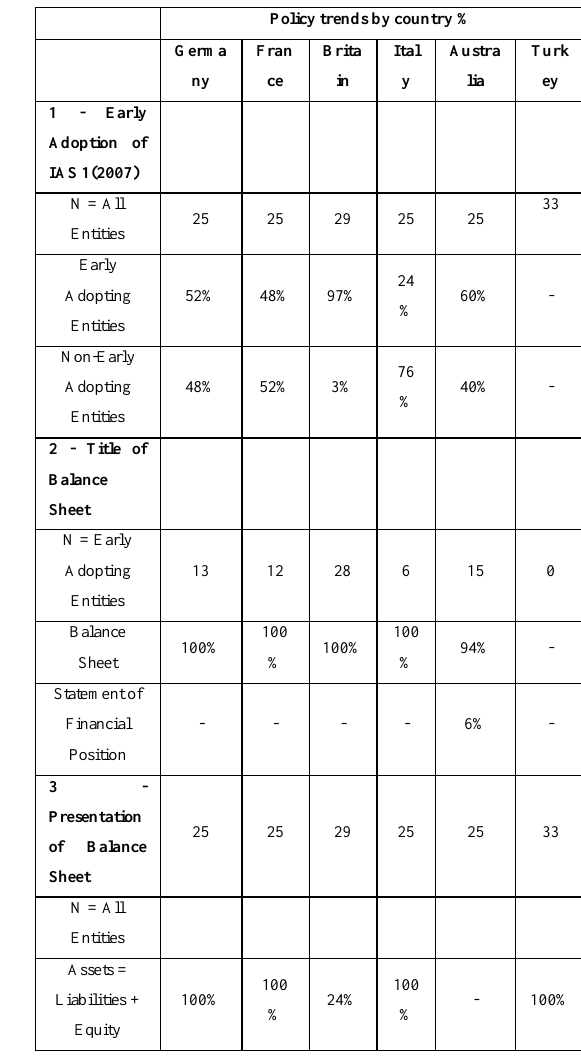
Table 2: Trends in Alternative Accounting